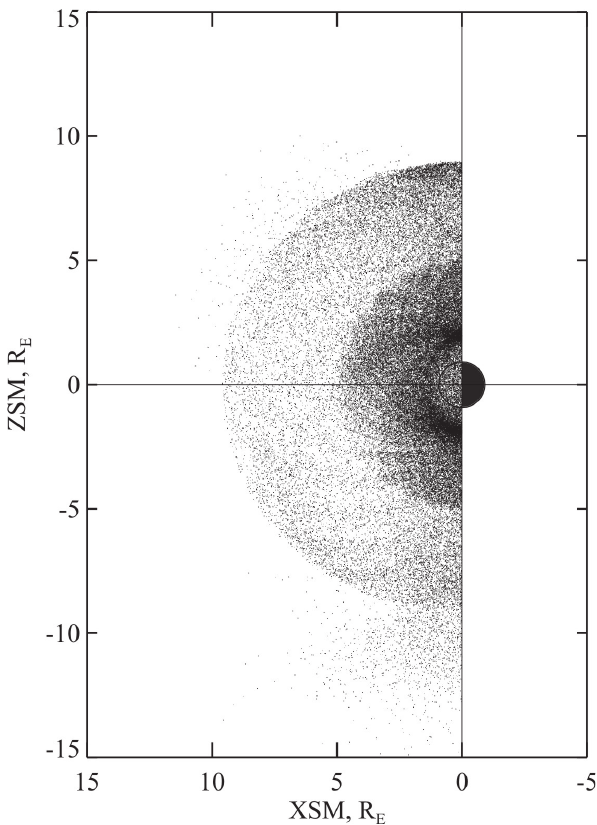
Fig. 3. Same as in Fig. 2, but for the crossing on 4 September 2001, when both IMF B y and the spikes of B y during the cusp crossings were